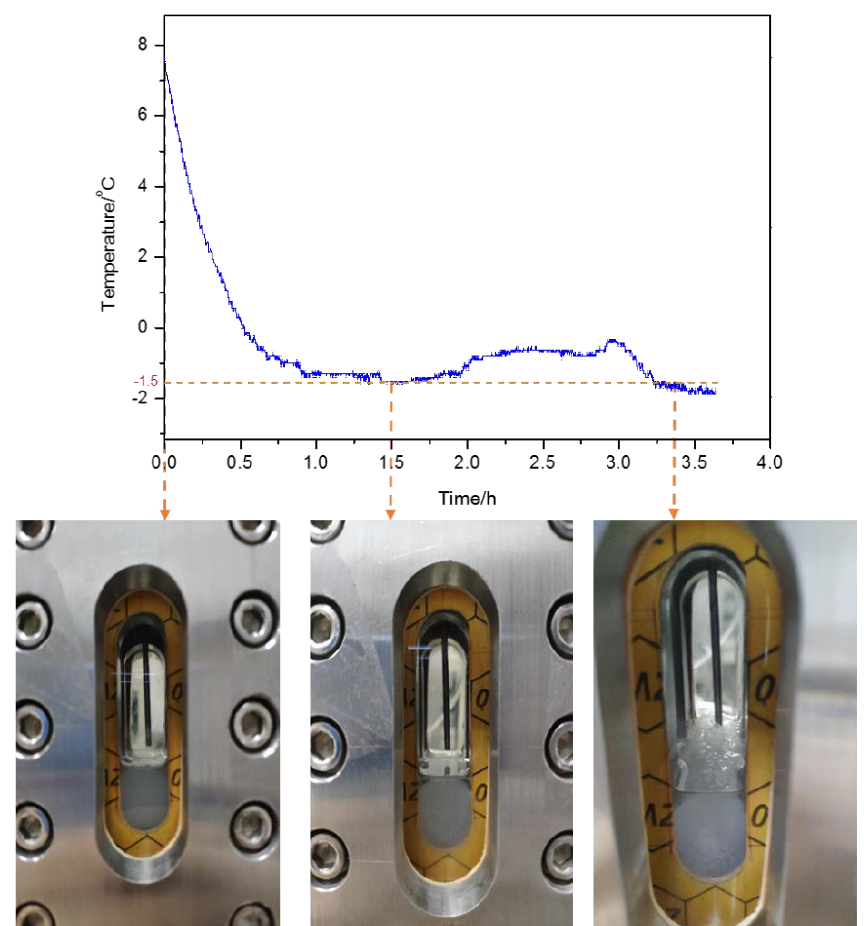
Figure 12. Phase T-t diagram of 5 v % CP solution.